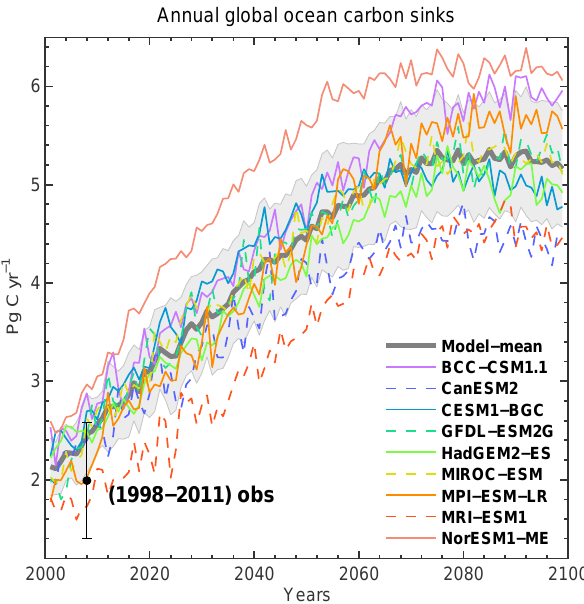
Figure 1. Time series of annual ocean carbon uptake as simulated by nine ESMs for the 2001–2100 period. Thick gray line indicates the multi-model mean, shaded areas represent ± one standard devi- ation of the inter-model variations. The observation-based estimate (black circle) is from Landschützer et al.